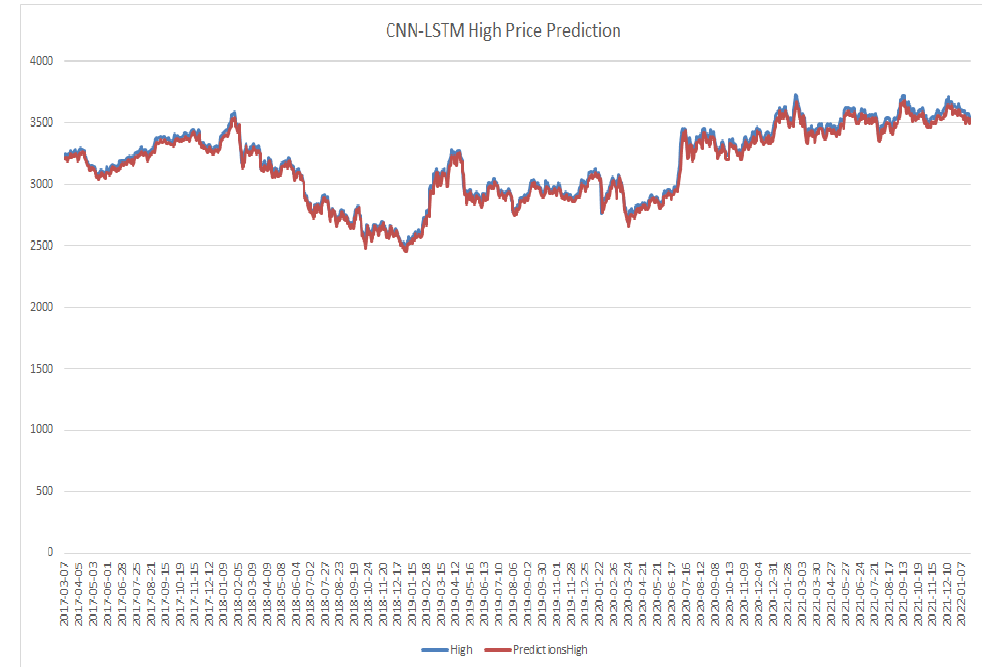
Figure 13. CNN-LSTM model high price